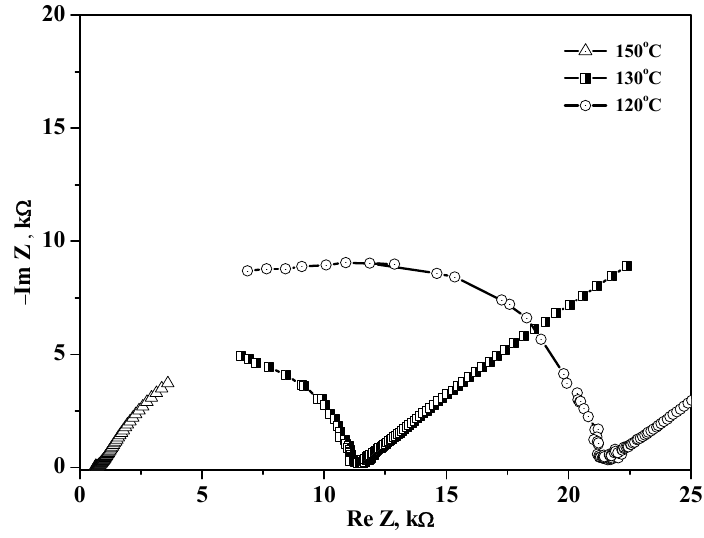
Figure 7. The impedance spectra of the (1 – x)Et 4 NHSO 4 − xSiO 2 composites (x = 0.8) measured at different temperatures.